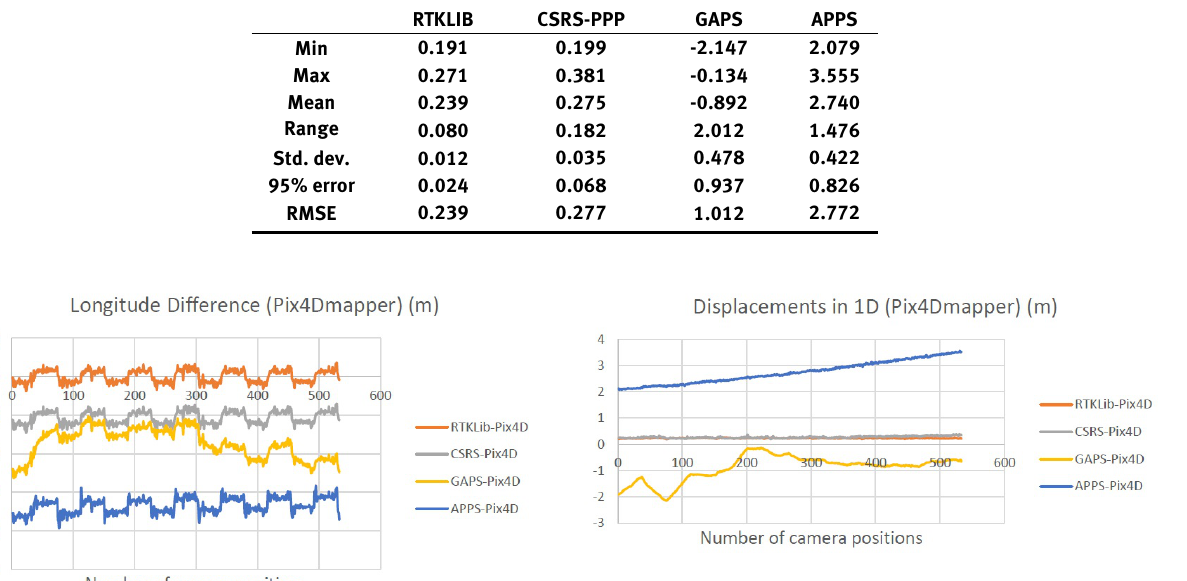
Fig. 15. Displacements in 1D between the coordinates produced by Pix4Dmapper and the software utilized in this